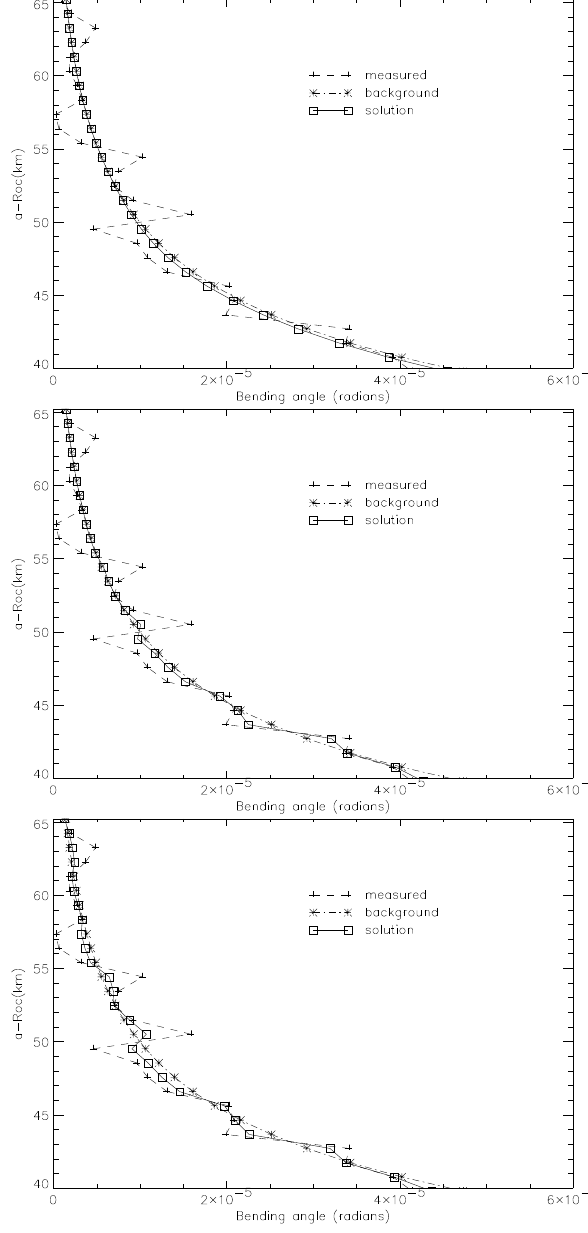
Fig. 3. Illustrating the smoothing of corrected bending angles for JPL profile ‘95-07-01-06:22met-gps16’ using (a) Eq. 6, (b) Eq. 8 and (c) Eq. 9. The vertical axis is ‘impact parameter minus radius of